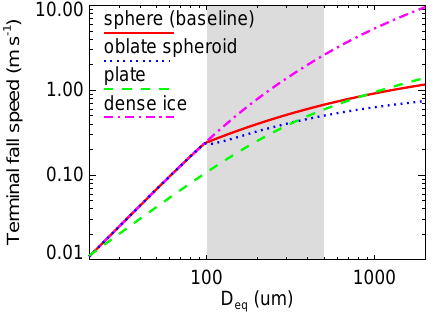
Figure 7. Vertical profiles of fractional hydrometeor diffusional growth occurring as vapor deposition on ice ( f vap , in which zero corresponds to no depositional growth of ice and unity indicates that only ice is growing from vapor diffusion) and saturation vapor ratio with respect to liquid water ( S ) for simulations in Fig. 6. Horizontal lines as in Fig. 4. Details provided in text.